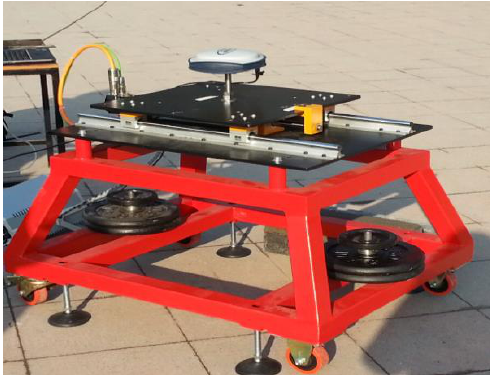
Figure 2. Trendless Time Series of VRS Method